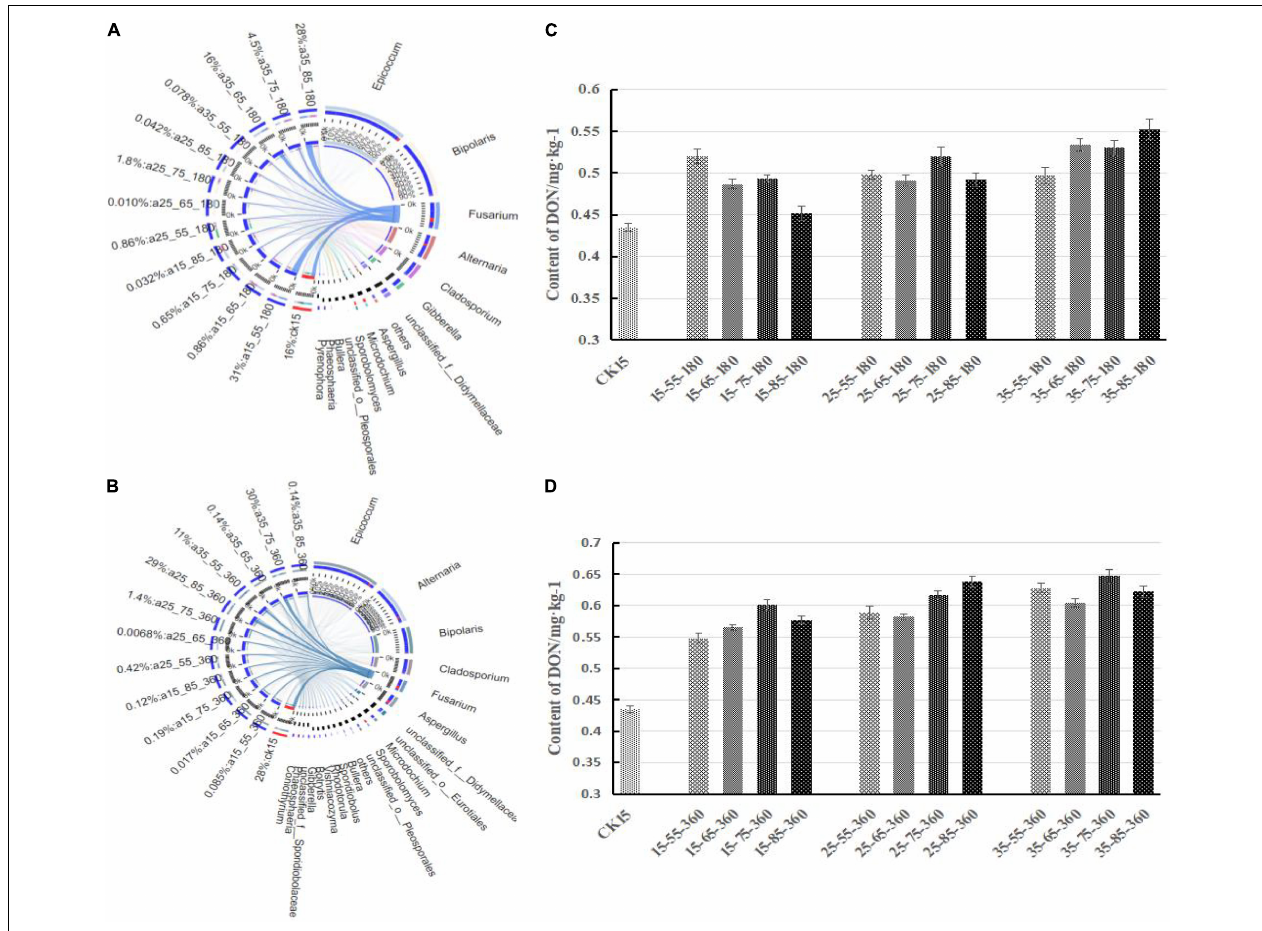
FIGURE 5 | Correlation between the Fusarium and DON content different storage conditions. Correlations between samples and species were analyzed using Circos software to obtain the proportion of dominant species in each sample. The bar width of each genus represents the proportion of the genus in the sample [ (A) storage 180 days; (B) storage 360 days]. On the right is the DON content after storage for 180 days (C) and 360 days (D) .